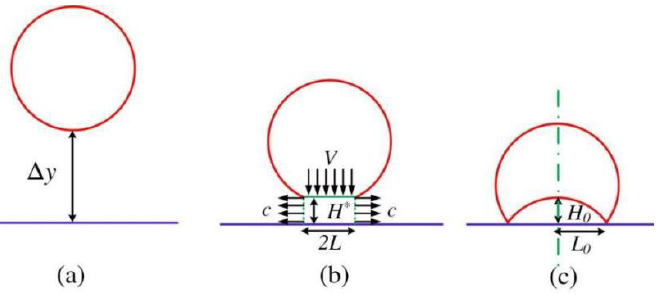
Figure 2. Dynamics of air entrapment: ( a ) Initially, the droplet resides ∆ y away from the substrate; ( b ) compression just begins; ( c ) the first contact. L 0 is the initial contact radius, different from L . ble to that of the liquid inertia so that the sign of the bottom curvature could be